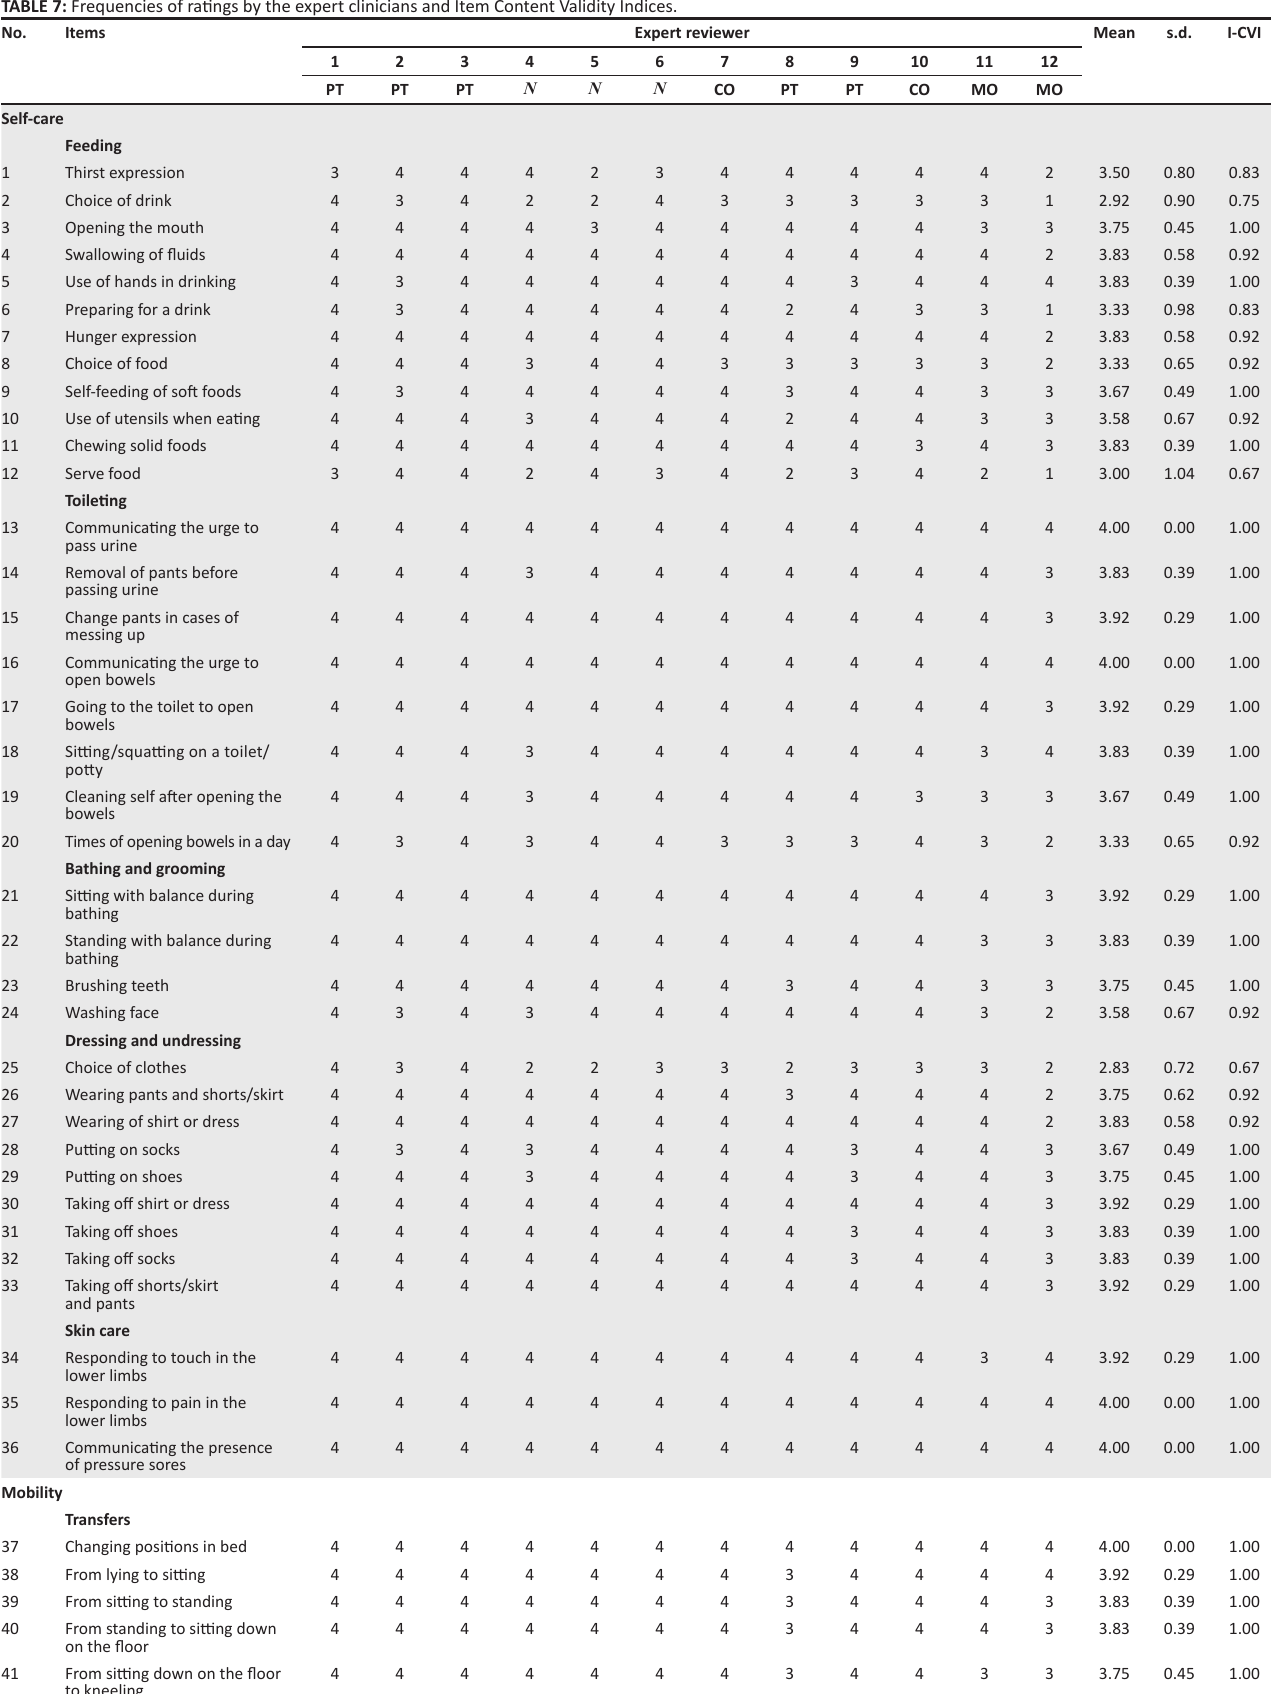
TABLE 7: Frequencies of ratings by the expert clinicians and Item Content Validity Indices.